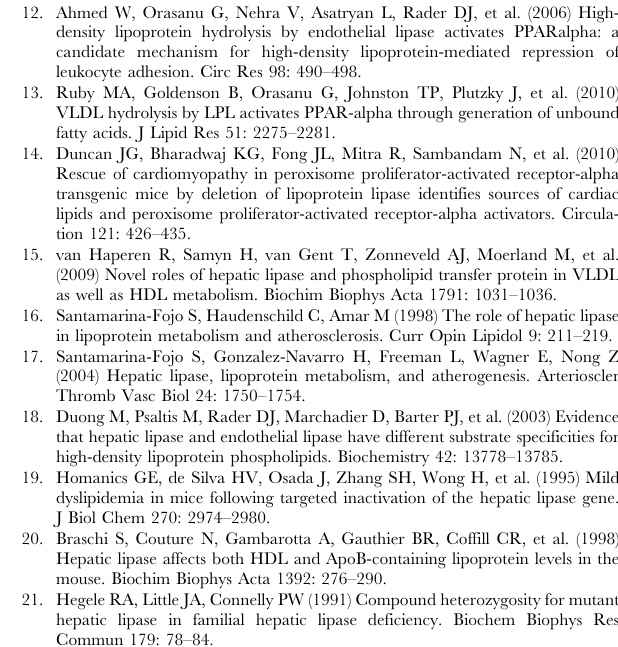
Figure S1 Catalytic mutant HL expresses similar pro- tein levels, but has no triglyceride hydrolase activity. Left Panel. Control vector, HL or HL catalytic mutant expression vectors were transfected into COS cells. 24 hours after transfec- tion, heparin (10 Units) was added to the media to release the lipase from the cell surface. Both media and cell lysate were collected for western blot. Right Panel. Media collected from above was used in triolein activity assay. (TIF) Figure S2 SiRNA knockdown of PPAR d achieved an 80– 90% knockdown of PPAR d expression. HUVEC were transfected with siRNA for PPAR d or a scrambled control. Following lipoprotein stimulation, RNA was collected for analysis of gene expression. *p , .05 for siPPAR d versus siControl. (TIF) Figure S3 Physiologic HDL concentrations activate PPAR d , but not to the same degree as VLDL. COS cells were transfected with each of the human PPAR-LBDs and stimulated with HDL (1 mg/mL) as in Figure 1. Data are presented as relative fold change of luciferase/ b -galactosidase.